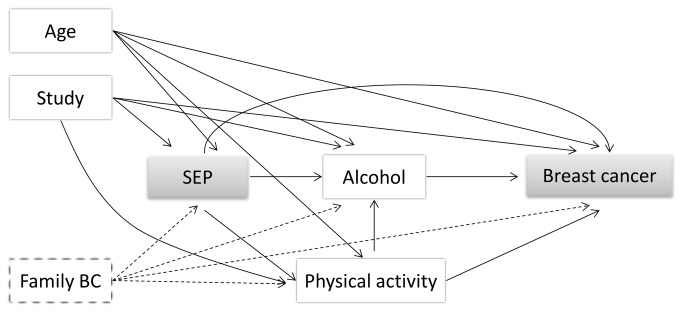
Model describing intertwined pathways, exemplified by the effect of SEP on breast cancer through alcohol consumption and physical activity. Arrows represent causal pathways and dotted lines represent unmeasured factors.